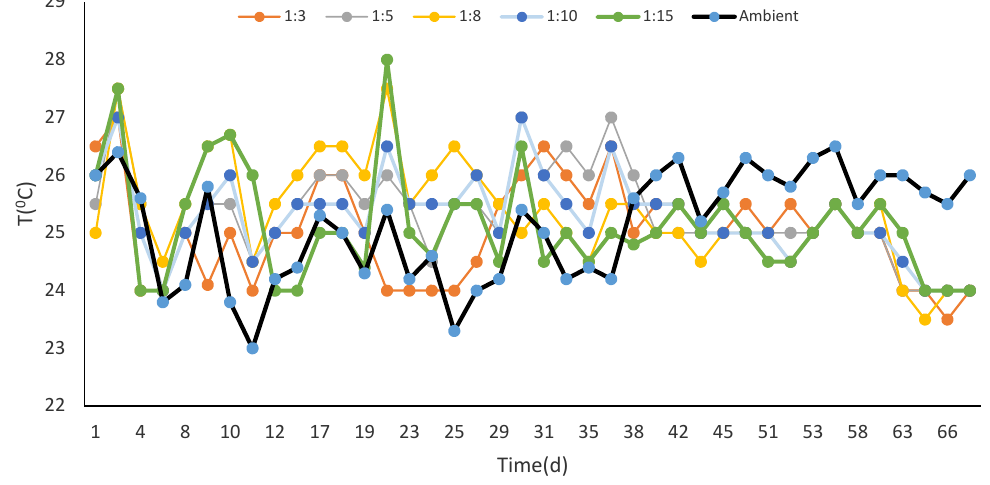
Fig. 4: Temperature profile during IVC for removing TPH